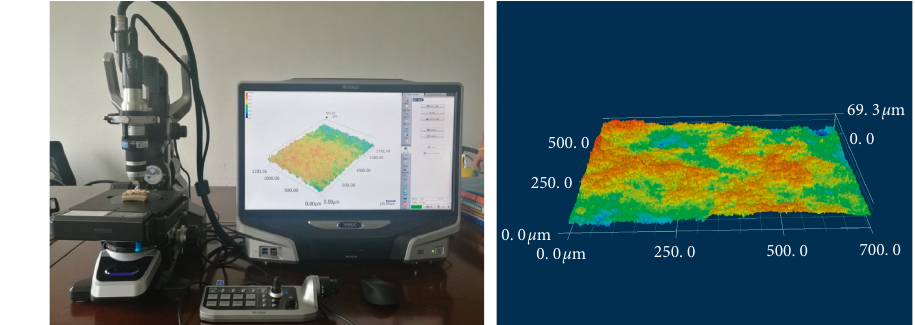
Figure 1: Illustration of 3D laser microscopy measurement.